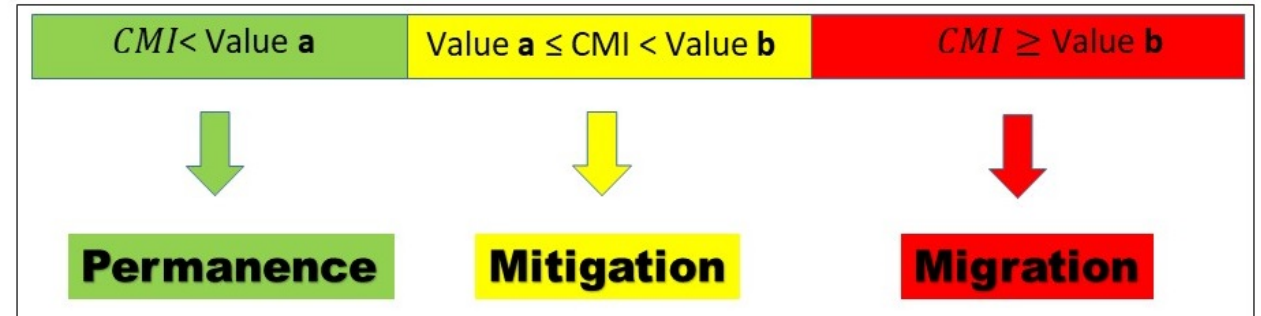
Figure 3. Stoplight value interpretation for the coastal migration index. Caption: Green: Range 1, PERMANENCE, CMI < lower limit of CMI (a value). The risk is lower for human settlements and human settlements can be maintained. Yellow: Rank 2, MITIGATION, between the lower (a value) and the intermediate (b value) limit. It is possible to mitigate the risk to human settlements with the execution of hydraulic works, i.e., to prevent extreme flooding and damage to property and infrastructure. Red: Rank 3, MIGRATION, CMI ≥ Intermediate limit (b value). The area has a high risk of impact from expected SLR, and human settlements will have to be relocated and existing infrastructure will have to adapt to those risk conditions. Real a and b values are presented in the results section.